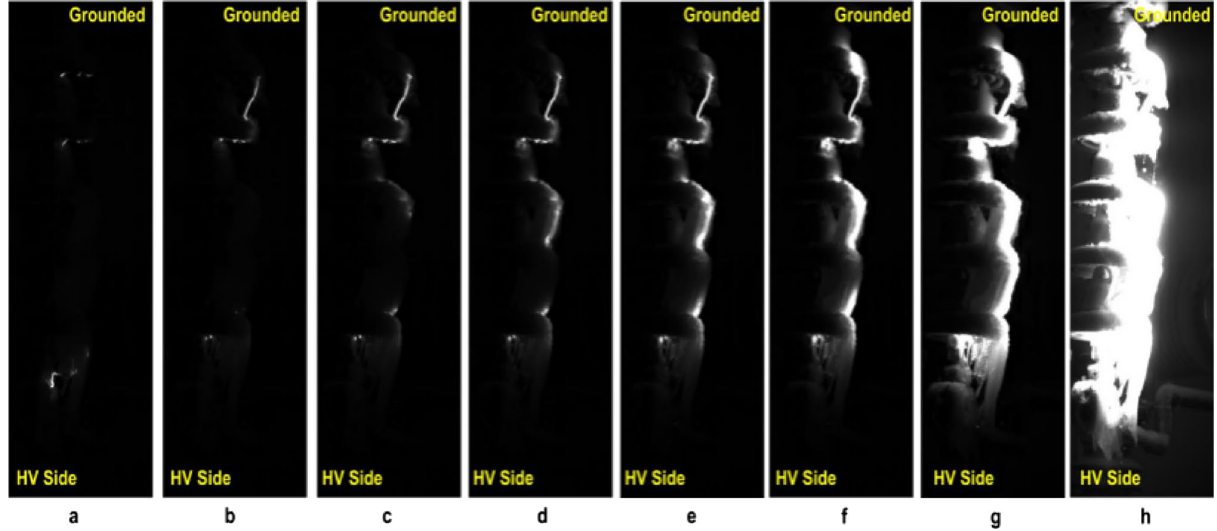
Figure 4. Process of arc discharges to flashover on the iced insulators: ( a ) Stage I(the initiation of test voltage), ( b ) Stage II, ( c ) Stage III, ( d ) Stage IV, ( e ) Stage V, ( f ) Stage VI, ( g ) Stage VII, ( h ) Stage VIII (the occurrence